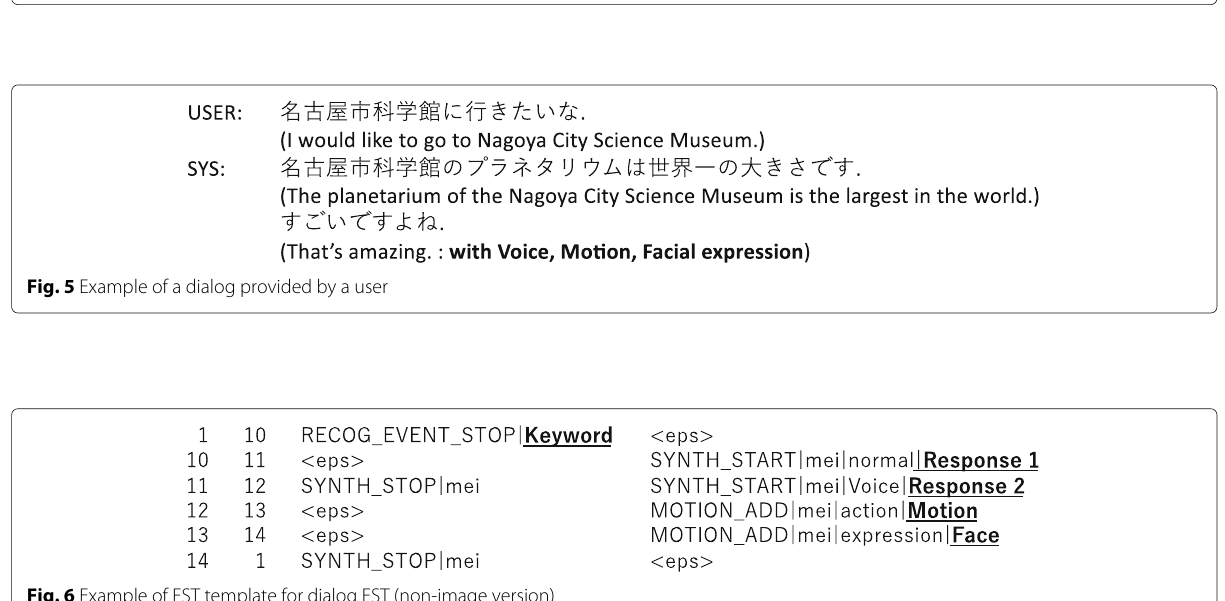
Fig. 4 Web screen allowing users to edit the system